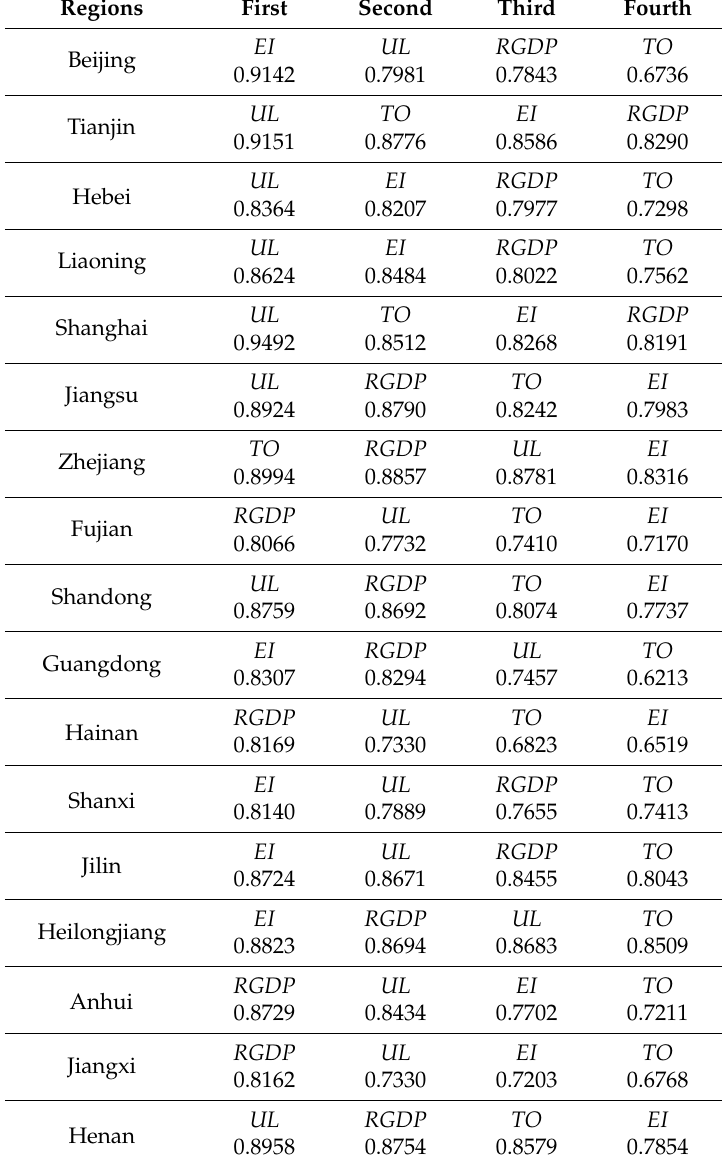
Table 1. Panel gray incidence ranking of influencing factors of CO 2 emissions.